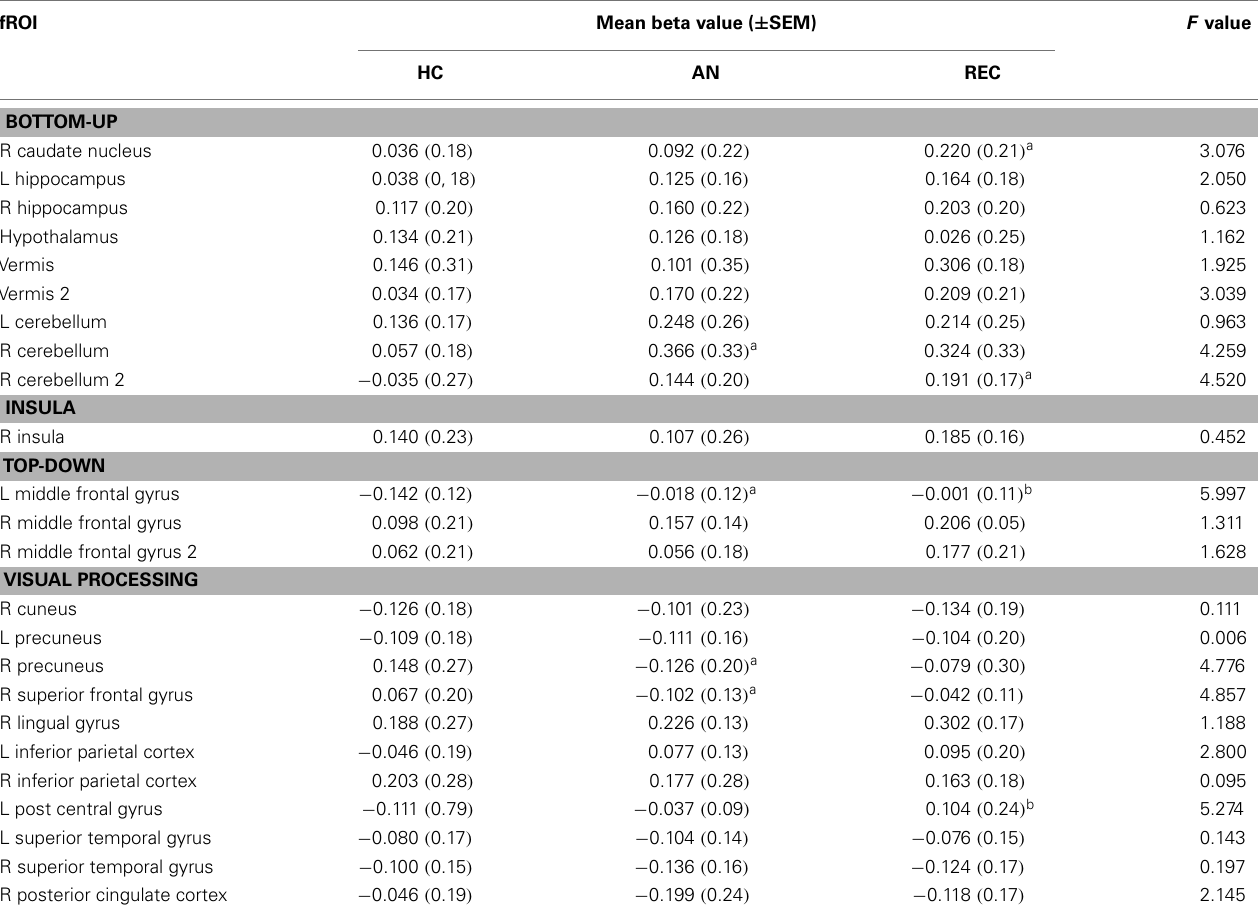
Table 2 | Between group differences in food-cue activation